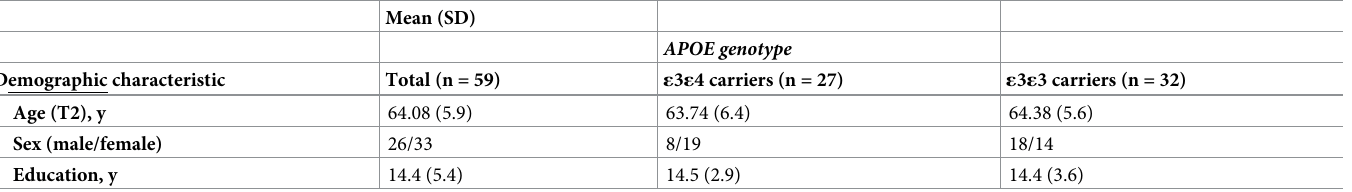
Table 1. Demographic characteristic of the sample.